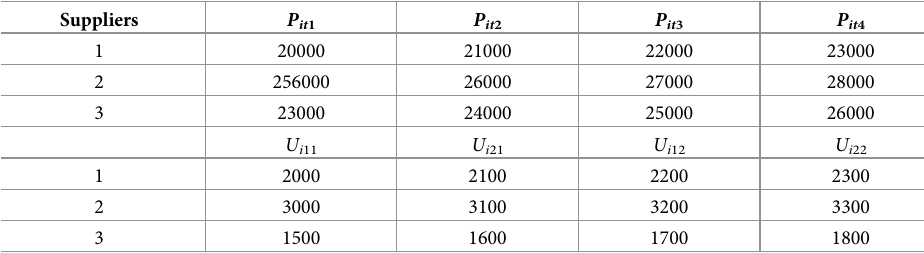
Table 4. Maximum production capacity and minimum ordered quantity.